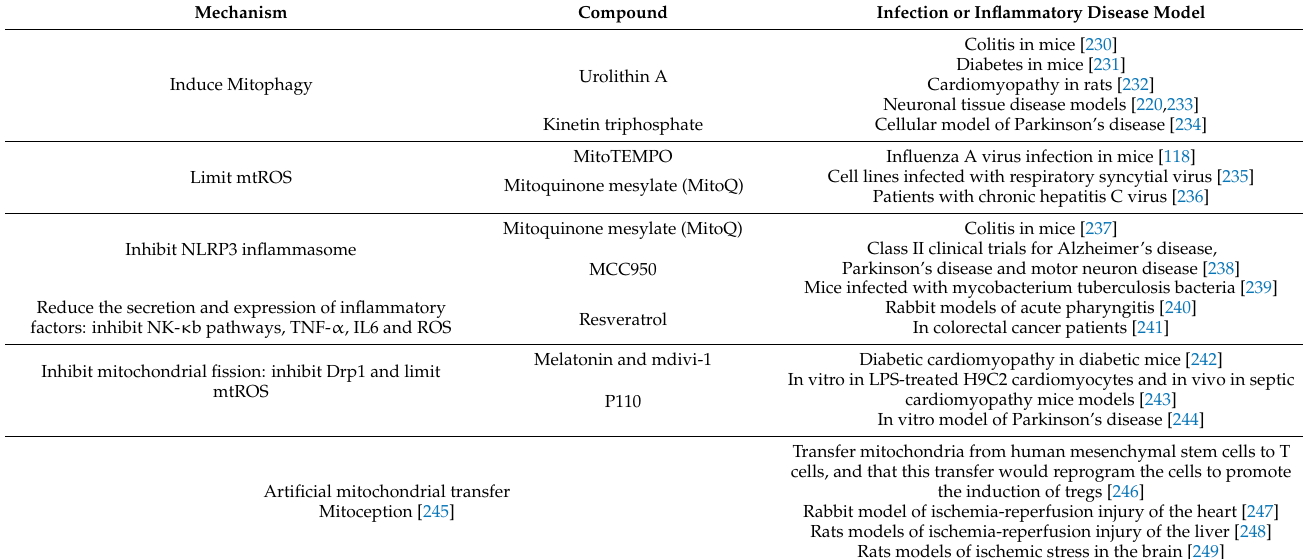
Table 2. Therapeutic strategies targeting mitochondria in inflammatory and infectious disease models. Mechanism Compound Infection or Inflammatory Disease Model Colitis in mice [230] Diabetes in mice [231] Urolithin A Kinetin triphosphate